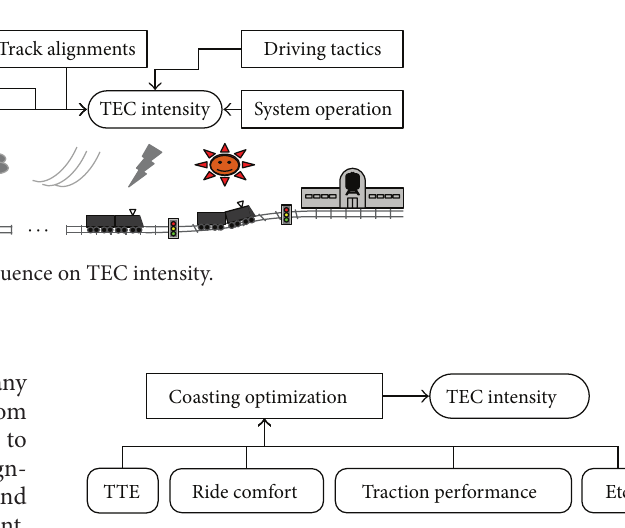
Figure 2: Coasting optimization for decreasing TEC